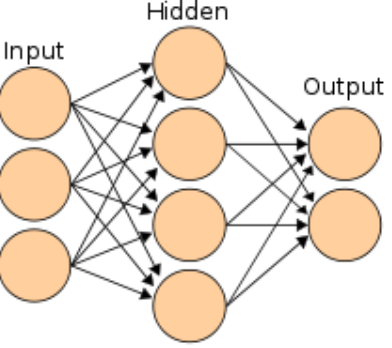
Figure 12. The interconnections of neural network with the group of